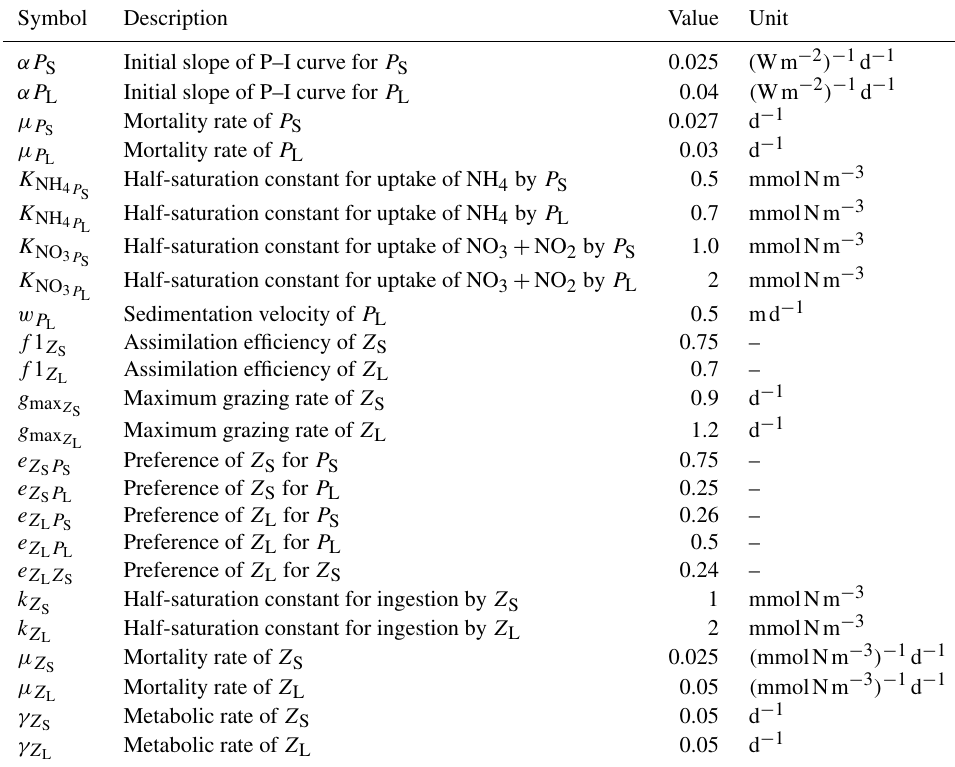
Table A1. Plankton parameters in the model. The complete list of biogeochemical parameters is given in Gutknecht et al. (2013a), and the values for the reference simulation are provided in Jose et al.